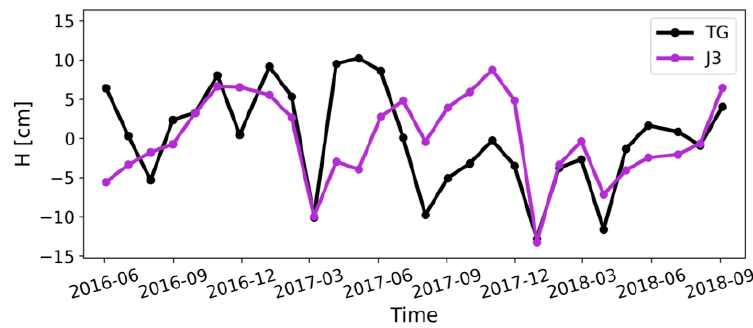
Figure 6. Time series of SLA (cm) obtained from the Jason-3 most correlated track points (dotted purple line) and tidal residuals (dotted black line) time series at the tide gauge site of Aranmore located at coordinates: − 8.5° E/54.99° N (northern cost of Ireland—IBI region). The mean value of each time series has been subtracted for comparison purposes.